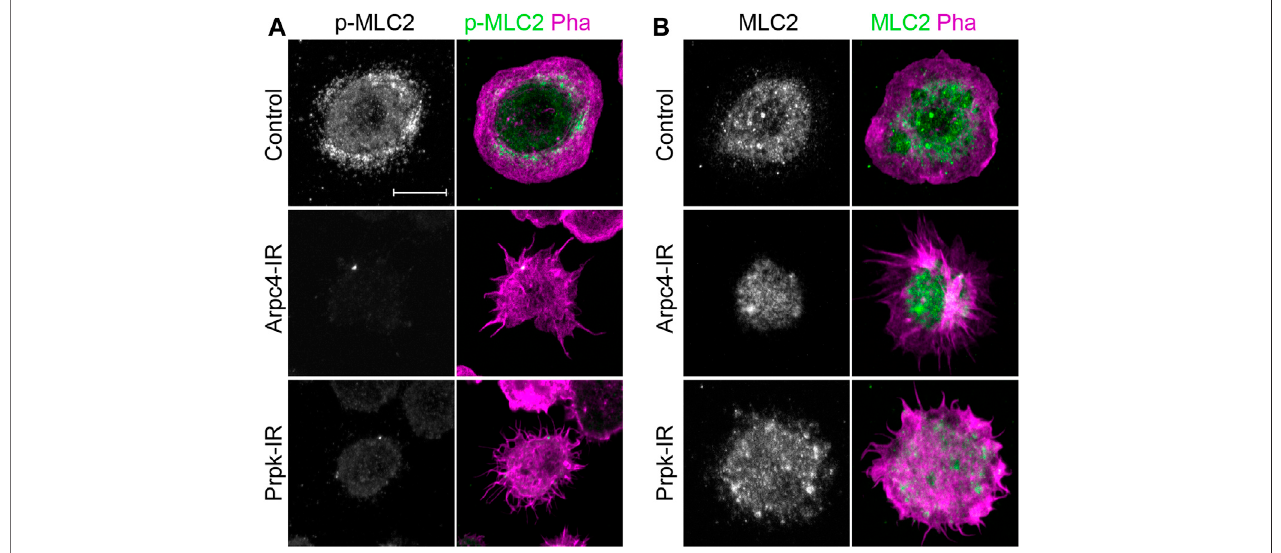
FIGURE 7 | PRPK is required for proper activation of myosin-II. (A) Hemocyte immuno fl uorescence showing the localization of phospho-myosin light chain II (p-MLC-II, green) and stained for F-Actin(Pha, magenta). (B) Hemocyte immuno fl uorescence showing the localization oftotal myosin light chain II (MLC-II, green). Scale bars: 10 μ